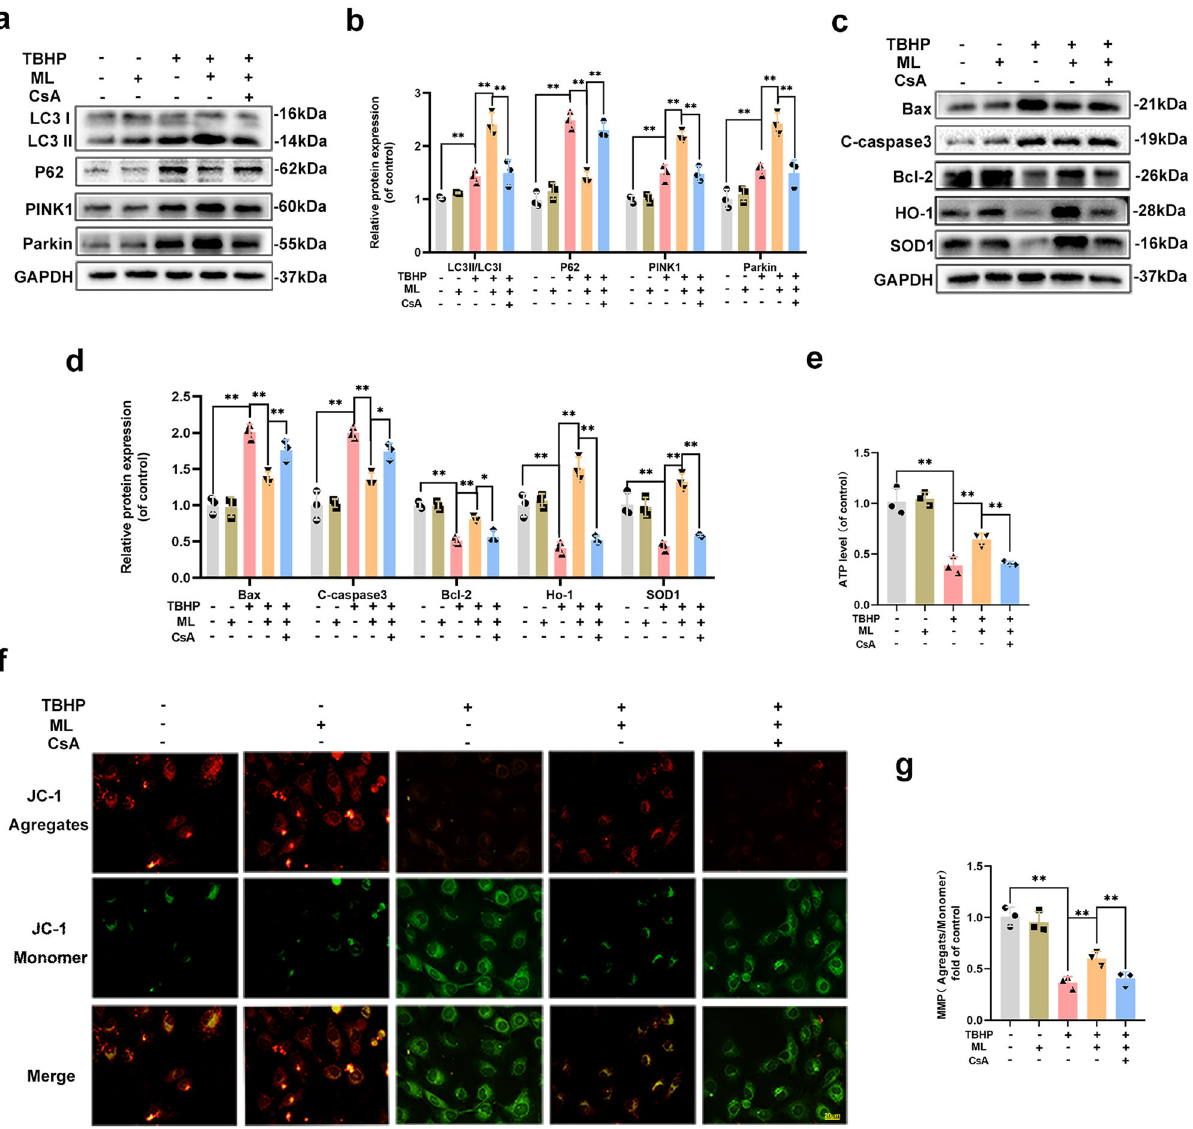
Fig. 3 ML protected HUVECs from TBHP induced injury in a mitophagy-dependent manner. a , b The protein expression level of LC3-II, p62, Pink1, and Parkin in HUVECs was quanti fi ed and showed by a histogram. c , d Expression and quanti fi cation of apoptosis-related and oxidative-related proteins Bax, C- caspase3, Bcl-2, HO-1, and SOD1 were measured by western blot. e , f JC-1 probe was performed to detect the change of MMP and was quanti fi ed and showed by a histogram (bar: 20 μ m). g ATP production in HUVECs was measured by an ATP detection kit and showed by a histogram. All experiments were performed at least 3 times ( n ≥ 3). Data are presented as mean ± S.D. n = 3, ** P < 0.01, * P <